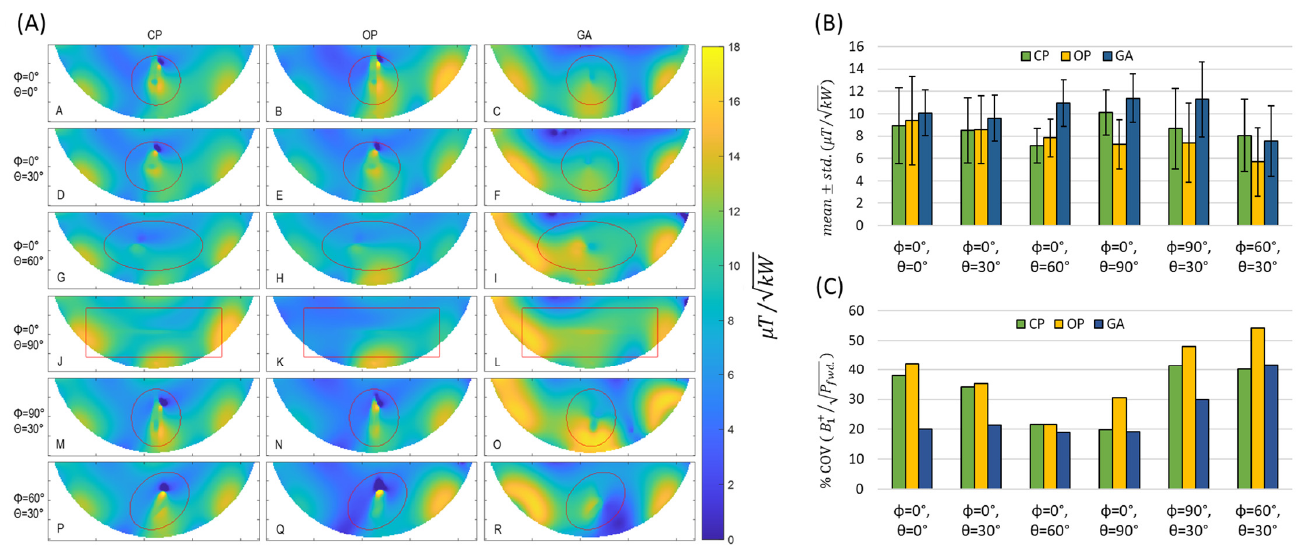
Figure 7. ( A ) Transversal experimental 𝐵 (cid:2869)(cid:2878) maps obtained for the tissue-mimicking phantom using CP-, OP-, and GA-based transmission field shimming for several implant orientations (Labelled from A to R). The implant orientation is defined using polar ( θ ) and azimuthal ( φ ) angles in spherical coordinates by considering the origin of the coordinate system on the center of the implant. The ROI covering the phantom is indicated in red. ( B ) Mean ± std. and ( C ) % coefficient of variation in (𝐵 (cid:2869)(cid:2878) ) (cid:3493)𝑝𝑜𝑤𝑒𝑟 (cid:3007)(cid:3050)(cid:3031). (cid:3415) inside the ROI for different implant orientations (defined with polar ( θ ) and azimuthal ( φ ) angles with the origin of the coordinate system being placed on the center of the implant) using CP, OP, and GA transmission field shimming.